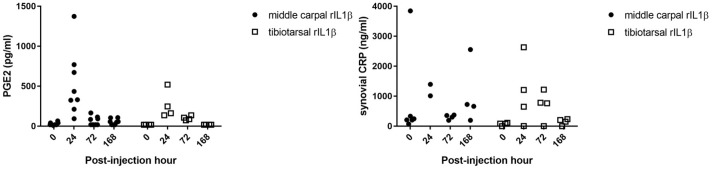
Synovial fluid biomarkers. There was no significant difference in synovial PGE2 or synovial CRP levels between MCJ and TTJ at any time point.